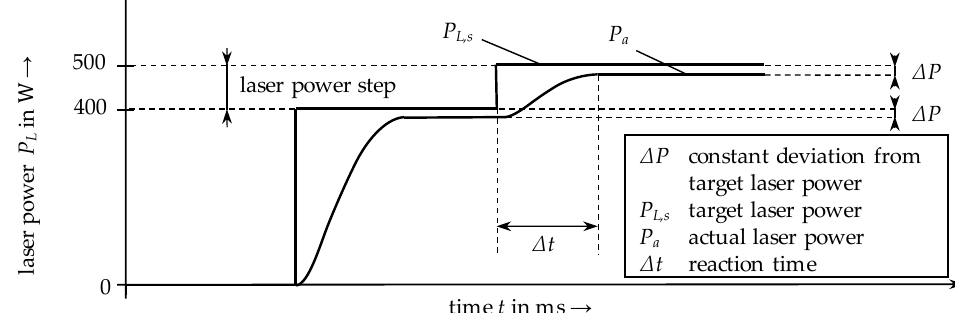
Figure 5. Schematic representation of the response of the actual laser power P a emitted by the laser beam source to a stepwise change of the specified targeted laser power P t .